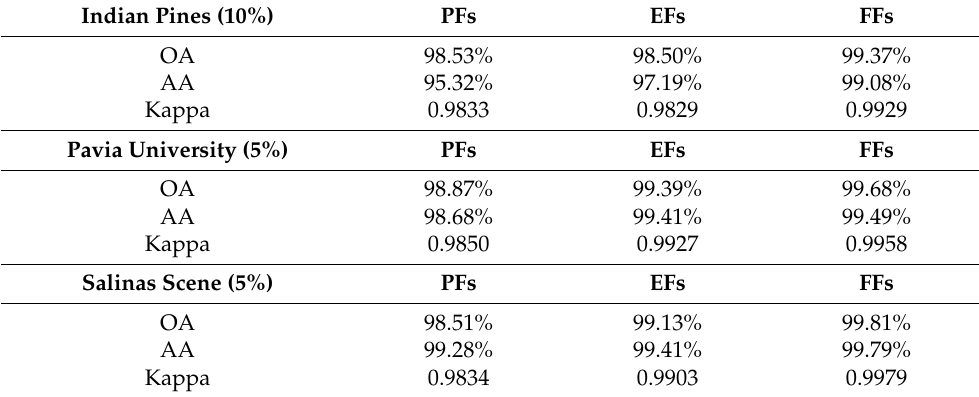
Table 2. The results of different features on different datasets. OA: overall accuracy; AA: average accuracy; PFs: principal component features; EFs: edge features; FFs: fusion features.